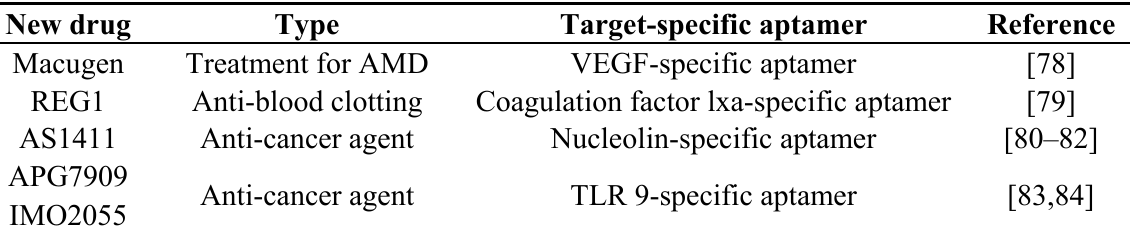
Table A2. Aptamer-based new